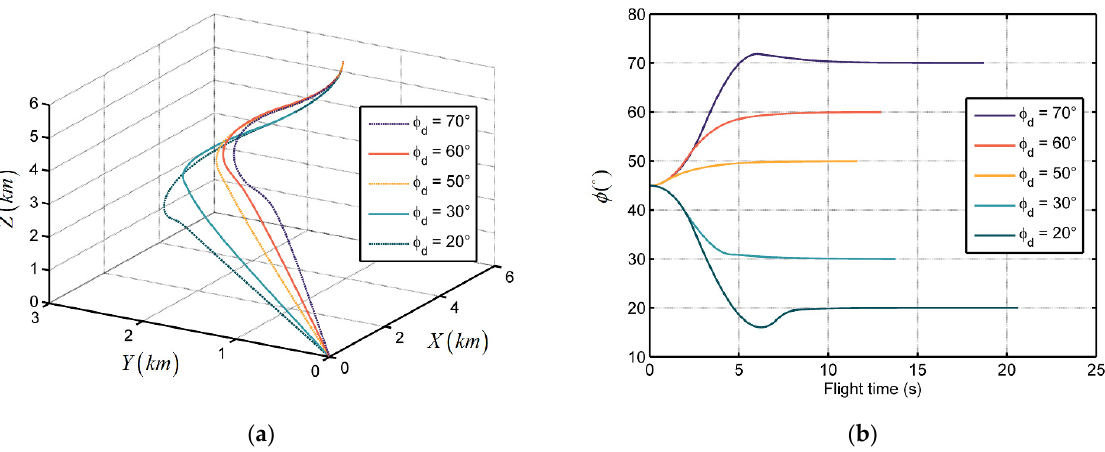
Figure 6. The performance of the proposed guidance law with different desired terminal azimuth angles: ( a ) Relative distance trajectories; and ( b ) LOS angles.